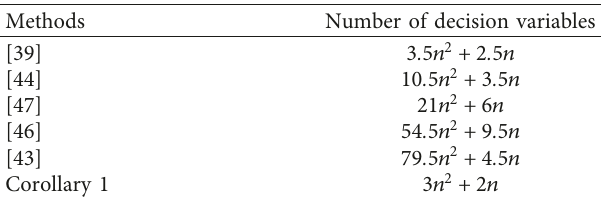
Figure 7: Comparative analysis of MAUB d Table 8: Comparative analysis of number of decision variables in Corollary